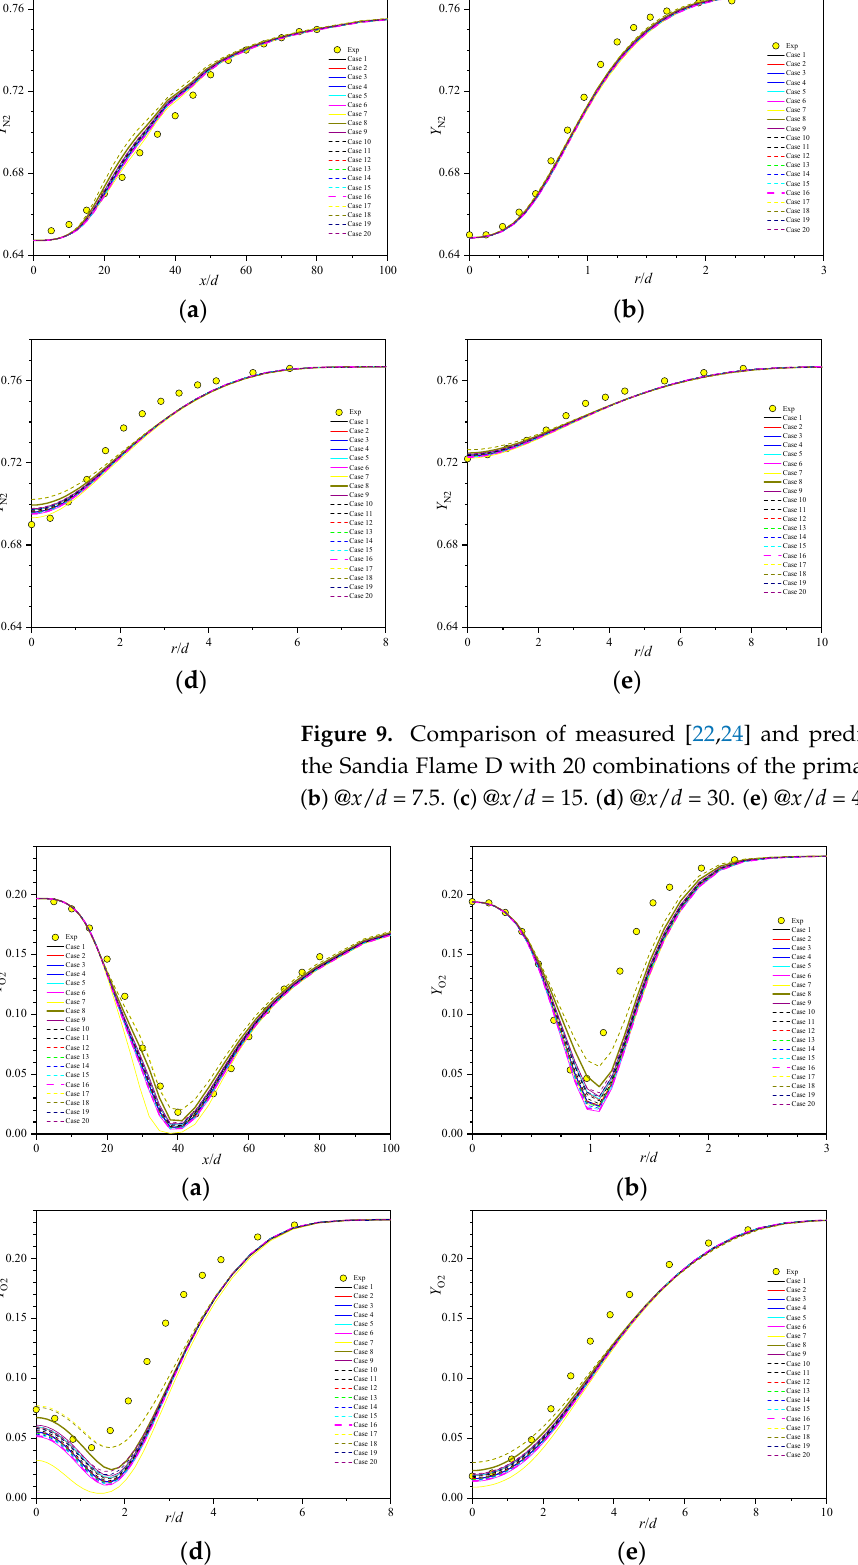
Figure 10. Comparison of measured [22,24] and predicted mean O 2 mass fraction profiles for the Sandia Flame D with 20 combinations of the primary EDC constants C D1 and C D2 . ( a ) @axis. ( b ) @ x / d = 7.5. ( c ) @ x / d = 15. ( d ) @ x / d = 30. ( e ) @ x / d = 45. ( f ) @ x / d =